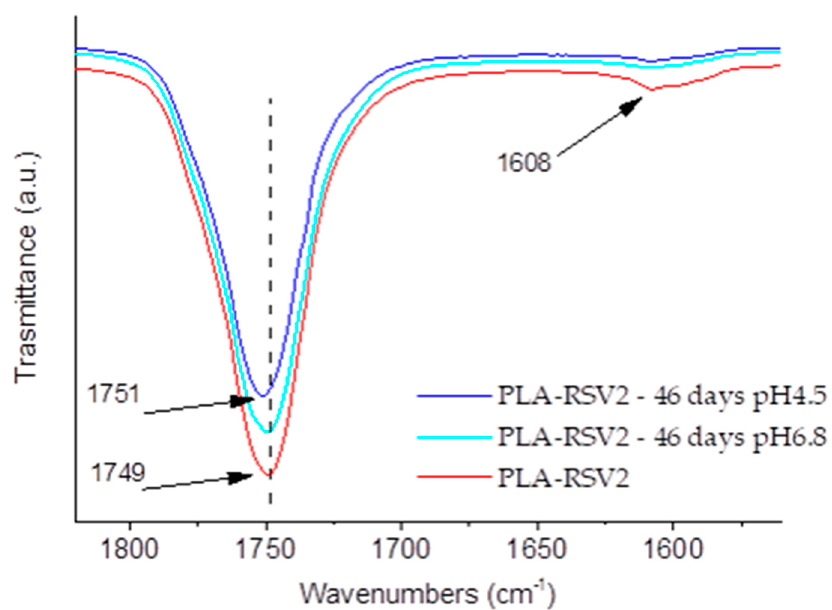
Figure 6. ATR spectra of RSV, neat PLA fibers, and PLA fibers containing RSV2 after the release test (pH 4.5 and pH 6.8—46 days) in the range of 1820–1560 cm − 1 .